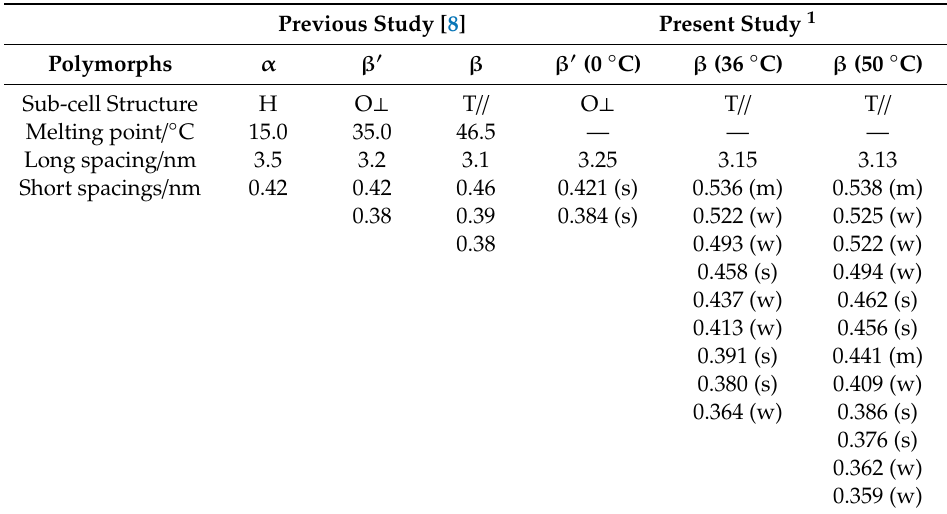
Table 1. Melting points and structural features of trilaurin (LLL)